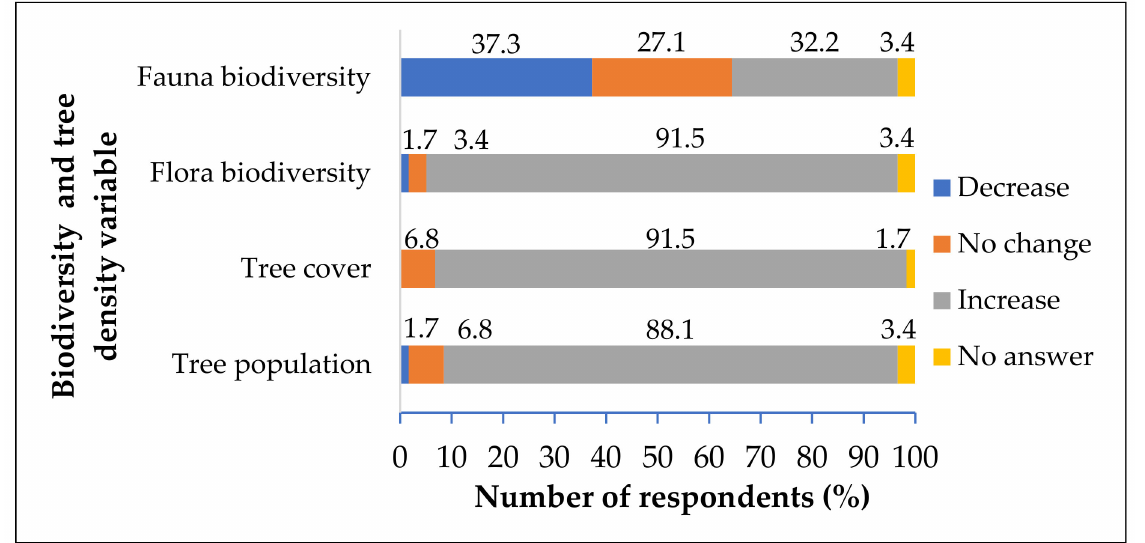
Figure 7. Impact of agroforestry development on certain biodiversity and tree density variables in WAR